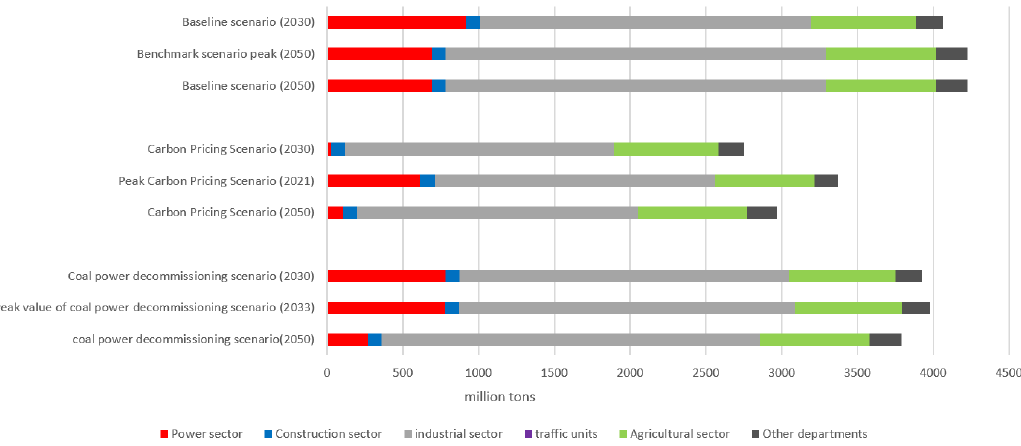
Figure 16. Change of carbon dioxide emissions in Inner Mongolia under the scenario of early re- tirement of coal power units.